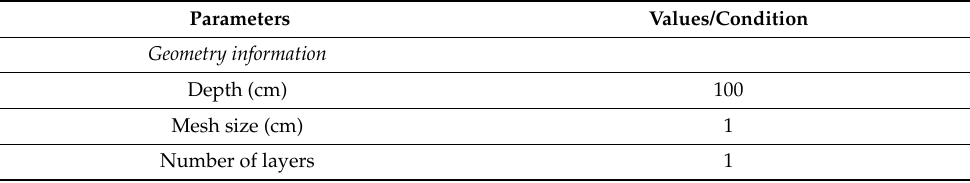
Table 2. Input parameters of Hydrus-1D